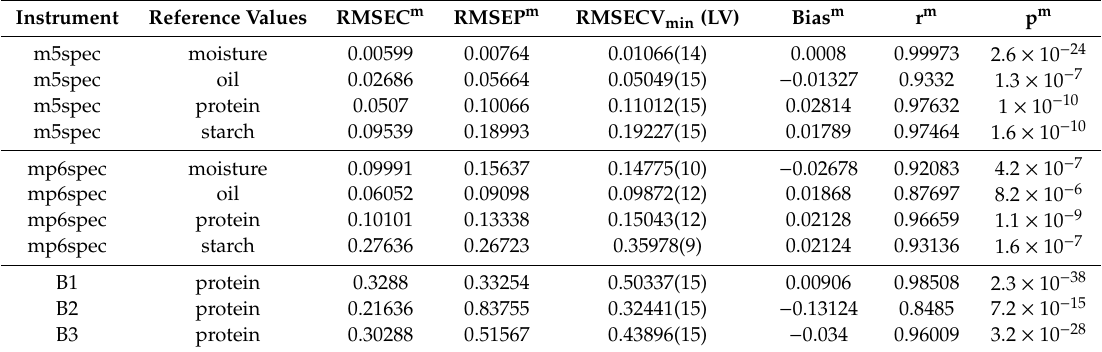
Table 1. Summary of the partial least squares (PLS) models and properties.